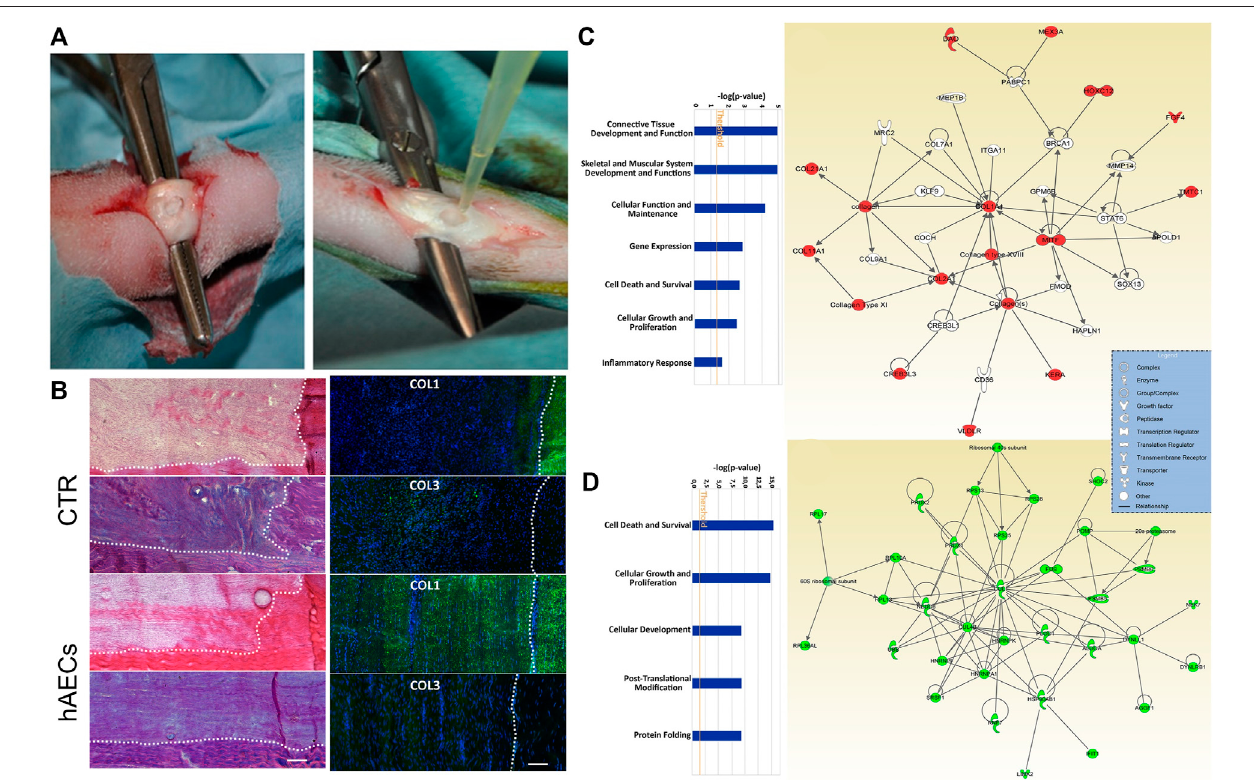
FIGURE 4 | Therapeutic potential of hAECs for early Achilles tendon defect repair through regeneration. (A) Circular defects of 5 mm created in the Achilles tendons. One defect was fi lled with fi brin glue, whereas the contralateral with 10 × 106 PKH26-stained cells suspended in fi brin glue (bottom); (B) Representative haematoxylin – eosin-,Heroviciandimmuno fl uorescentstainingofCTR(control)andhumanamnioticepithelialcell(hAEC)-treated tendons. (C) Keyfunctionsassociated withgenesfoundtobeup-regulatedinhAECsandthetop-scorednetwork; (D) Keyfunctionsassociatedwithgenesfoundtobedown-regulatedinhAECsandthe top-scored network. Copyright 2017